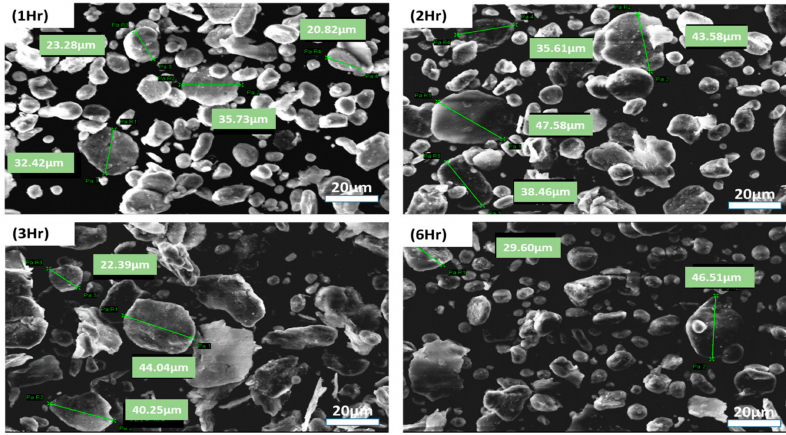
Figure 5. SEM images of the PVA coated Al powders ball milled at 200 rpm and different timings (1, 2, 3 and 6